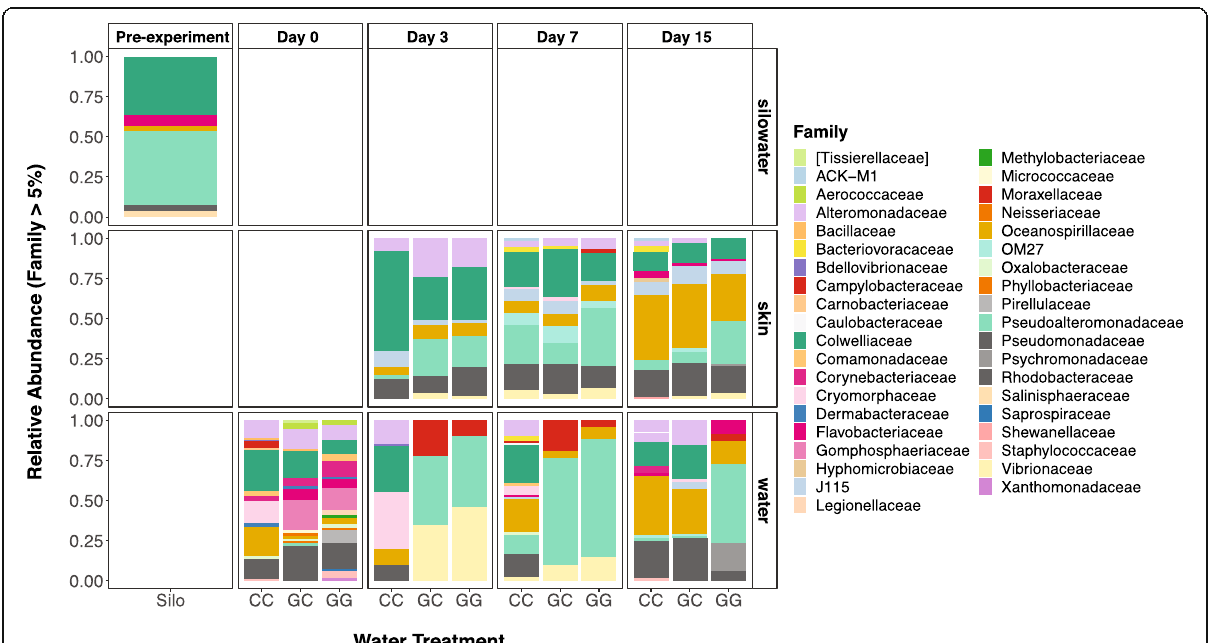
Fig. 2 Relative abundances of bacterial families greater than 5% of the total abundance in larval fish skin, experimental tank water, and hatching silo water microbial communities, faceted by date and treatment (For each sample type and day, n = 6 per treatment. Pre-experiment silo water n =